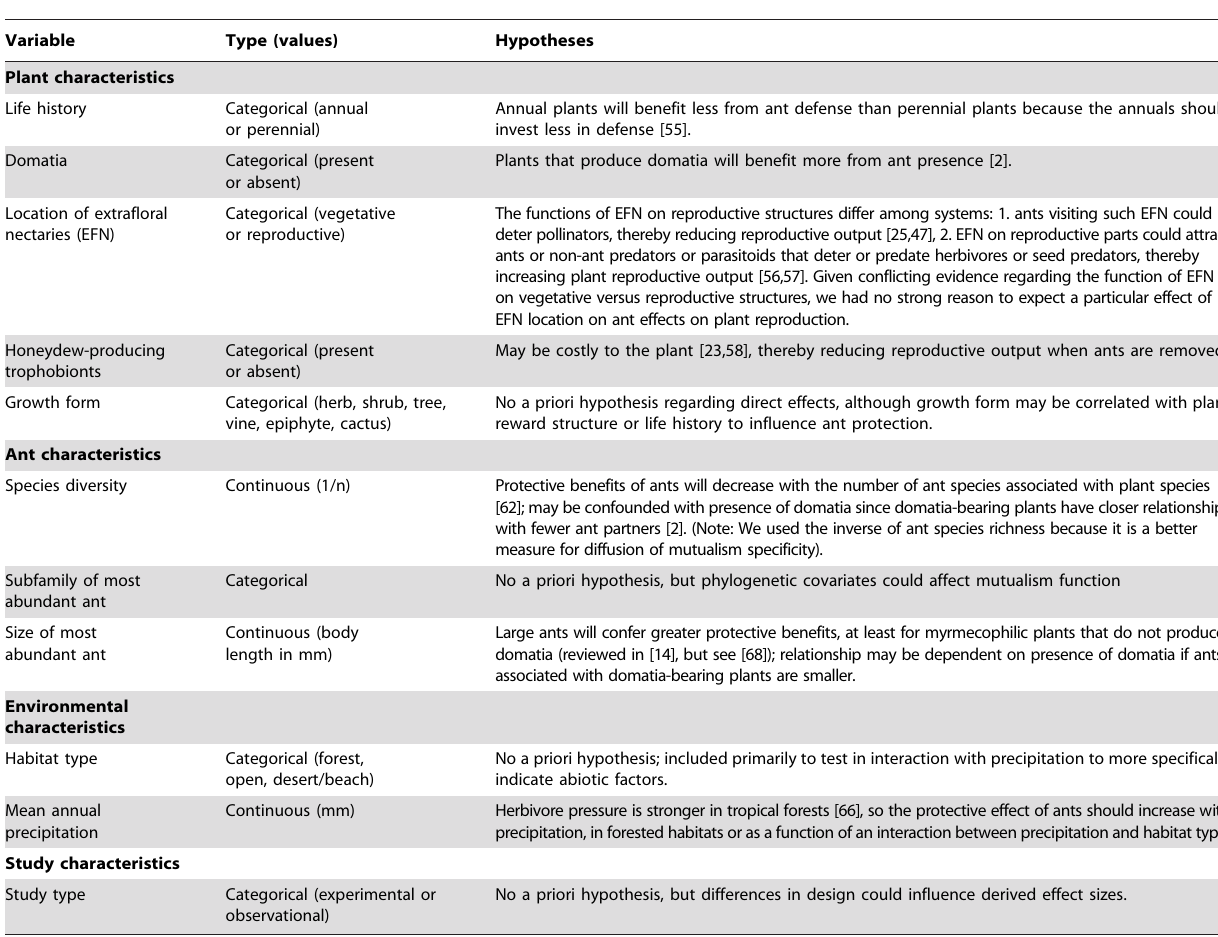
Table 1. Plant, ant, environmental, and study characteristics included in the meta-analysis, and hypotheses related to the potential effects of those